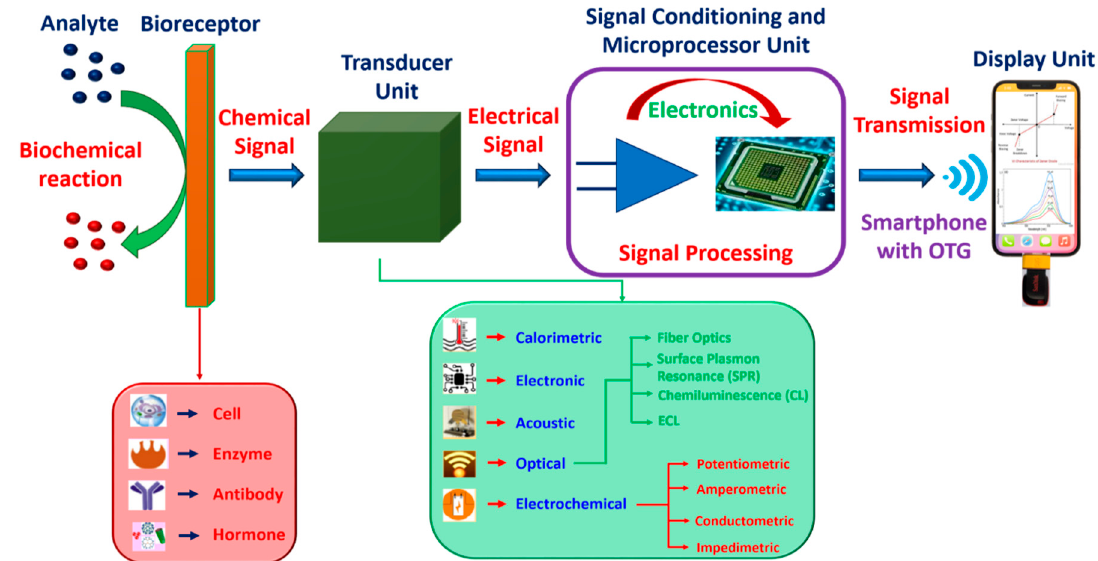
Figure 2. Schematics of a biosensor device consisting of various modules.